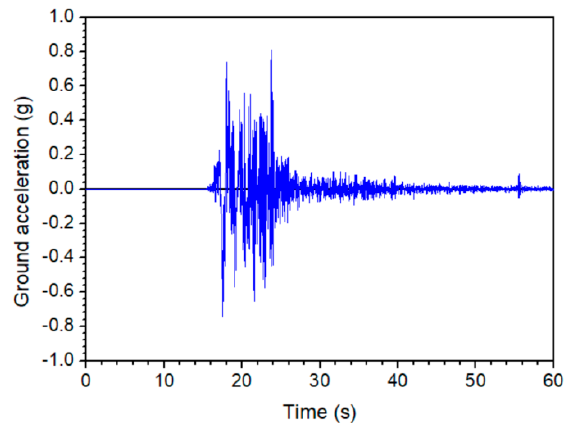
Figure 12. Time history of ground acceleration (Bam earthquake, Iran, 26 / 12 / 2003).